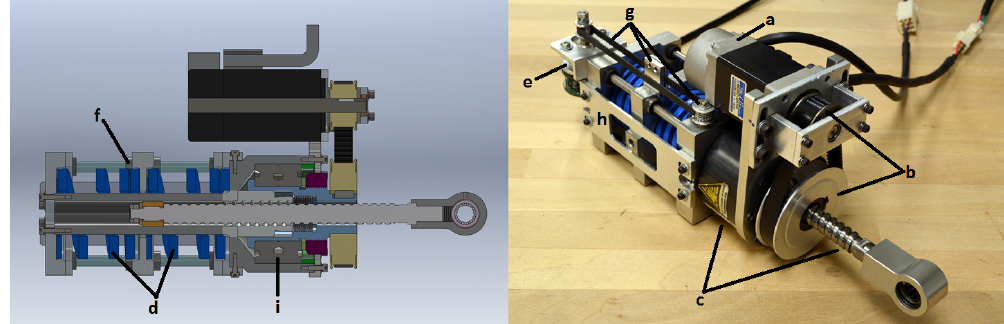
Figure 1. The SA-SEA and its cross section showing ( a ) Tamagawa Seiki Co., LTD TS4603 motor; ( b ) 60:26 pulley system; ( c ) TBI Motion BSHR01205-3.5 ball-screw mechanism; ( d ) Tohatsu Springs TL50-060; ( e ) Tamagawa Seiki Co., LTD TS5667N120 17-bit absolute encoder; ( f ) Misumi BGSTZ6-90 miniature ball bearing guides; ( g ) Force sensing mechanism; ( h ) Side bracket for easy assembly and rotational stiffness; ( i ) Misumi B7006-DB angular ball